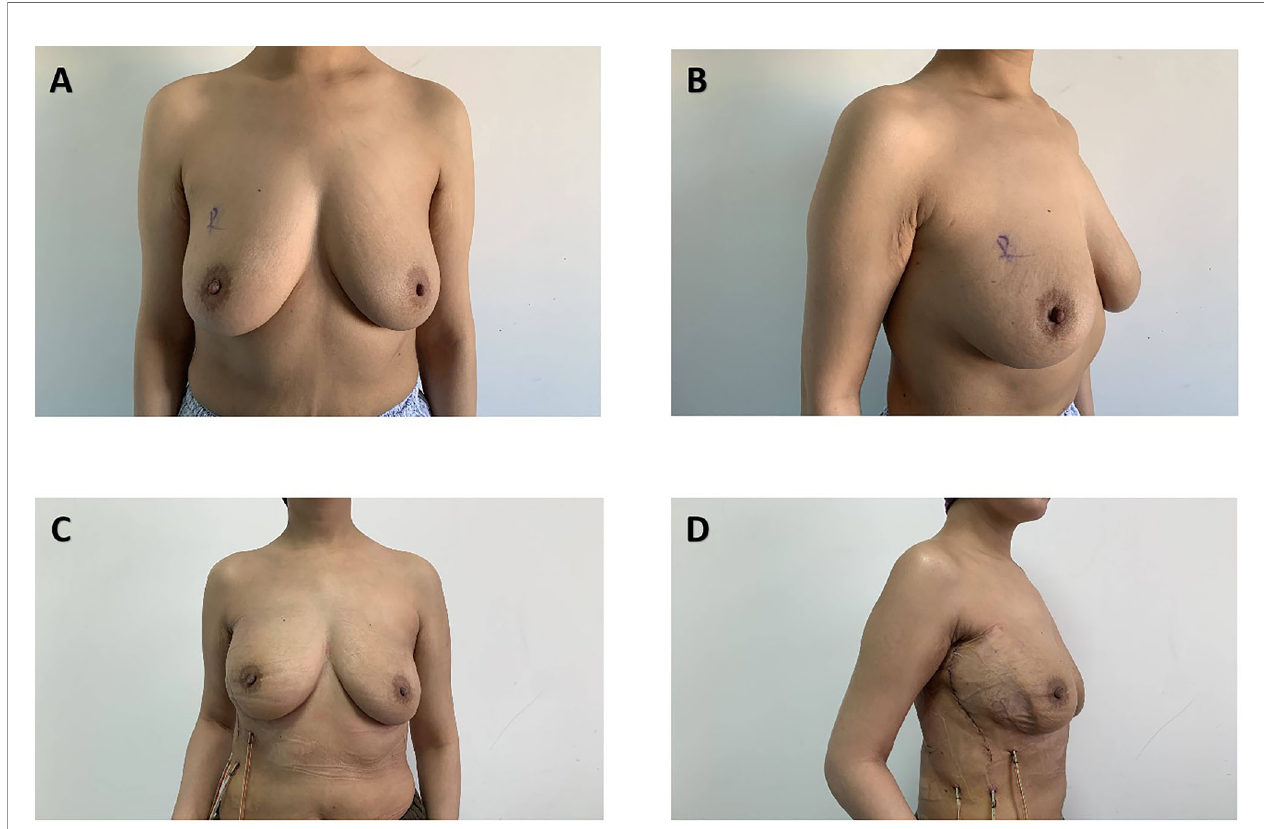
FIGURE 3 | Unilateral right nipple-sparing mastectomy with mini latissimus dorsi fl ap breast reconstruction. A 44-year-old woman who was diagnosed with invasive carcinoma of the right breast and axillary lymph node metastasis before surgery (A, B) . Photos at 7 days postoperatively (C, D)